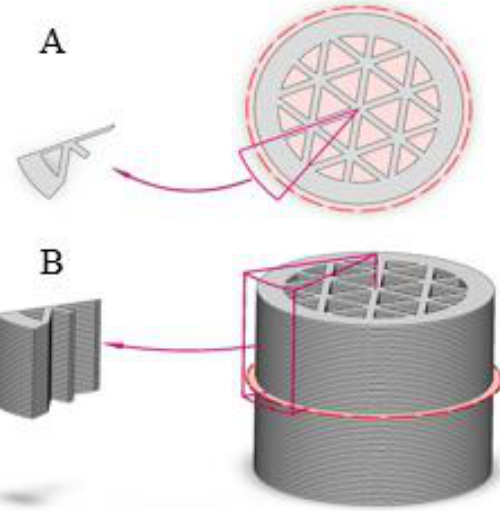
Figure 4. ( A ) Microscopic cross-section image of MEX-produced specimen with 100% infill. ( B ) The microscopic image from the top view of the MEX-produced specimen sample with 100% infill.